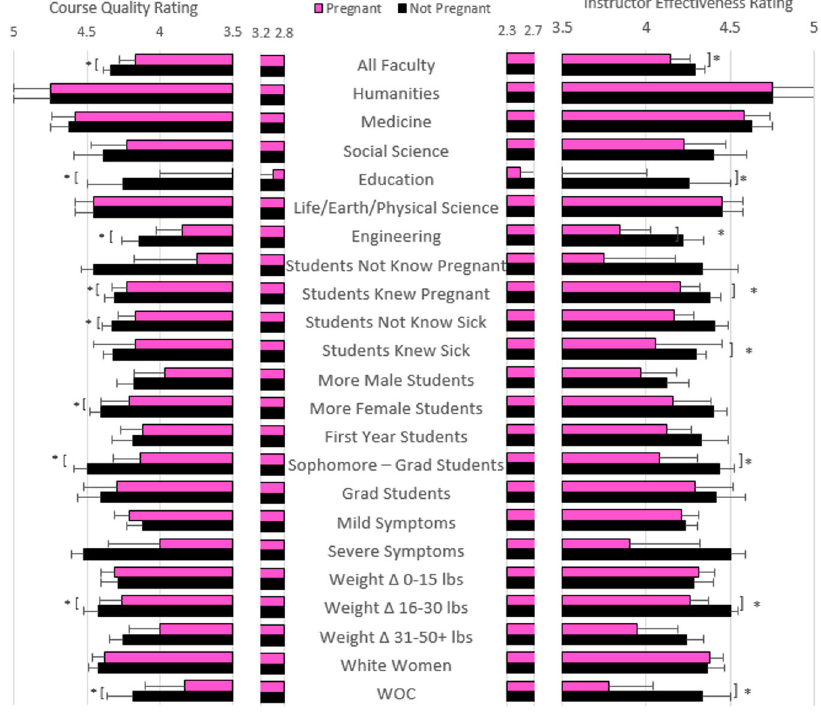
Fig. 2 The mean rating scores as reported by faculty of course quality and instructor effectiveness, separated by general fi eld, student knowledge of pregnancy, student knowledge of the illness, the severity of symptoms, weight gain, and instructor race. Error bars show standard error and asterisks indicate statistical signi fi cance ( p <